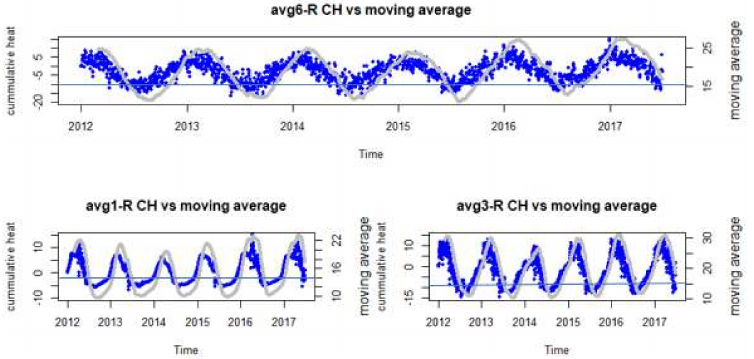
Figure 16. Avg6-R, avg1-R, and avg3-R cumulative heat ( ◦ C) (blue) against the 60-day moving average ( ◦ C)